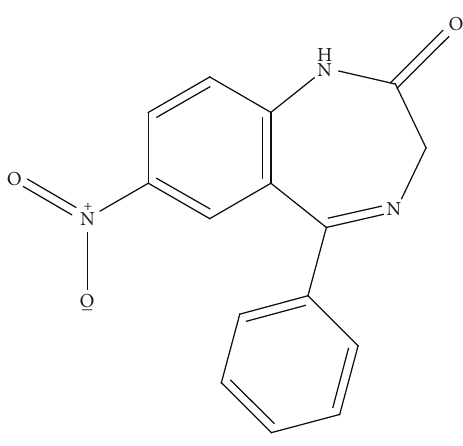
F 1: Structure of